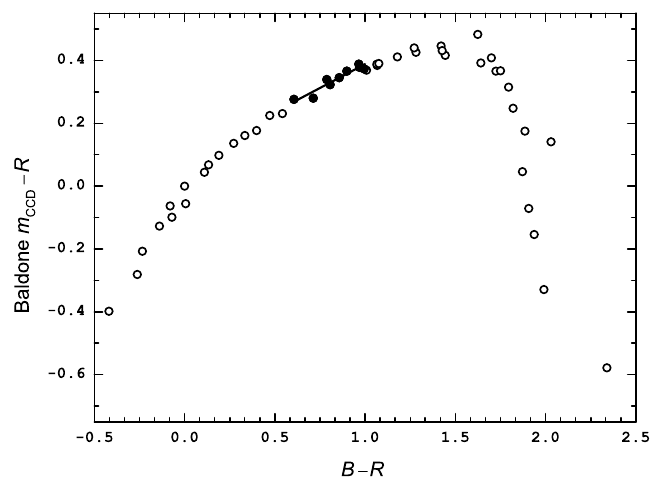
Fig. 6. The same as in Figure 5 but for CCD magnitudes of the Baldone Observatory.